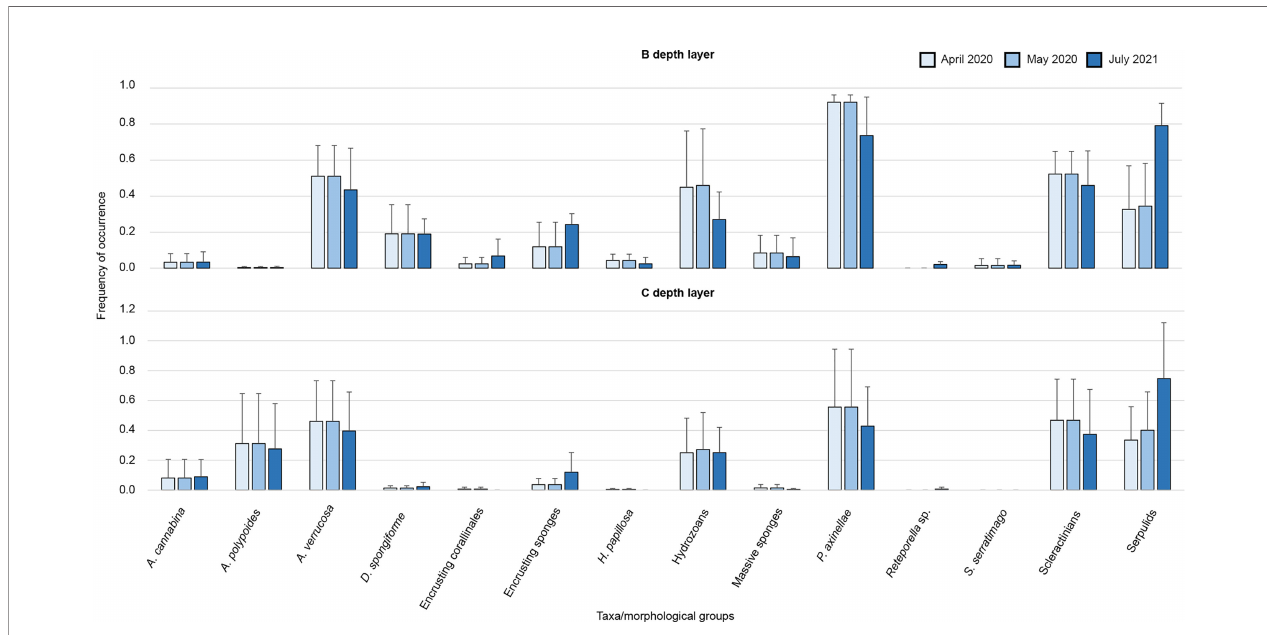
FIGURE 8 | Structure of the assemblage at the end (April 2020), one month after (May 2020), and fourteen months after (July 2021) the relocation activities. The nuclei assemblages have been separated to visualize differences among depth layers better. Furthermore, to improve the comprehension of the temporal trends, the lost nuclei have been excluded from the analysis.